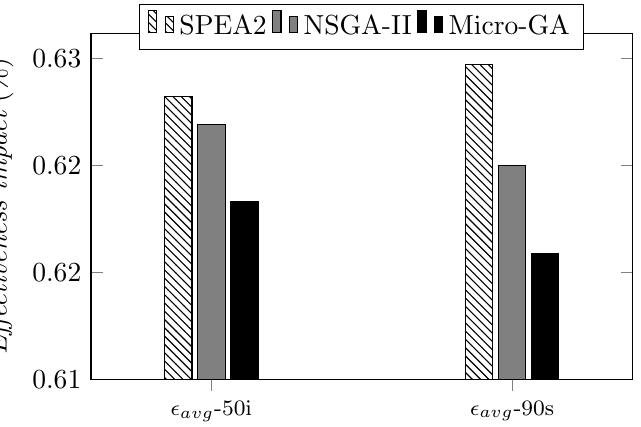
Figure 9. Comparison of average power savings for both stopping criteria as obtained by the applied algorithms.